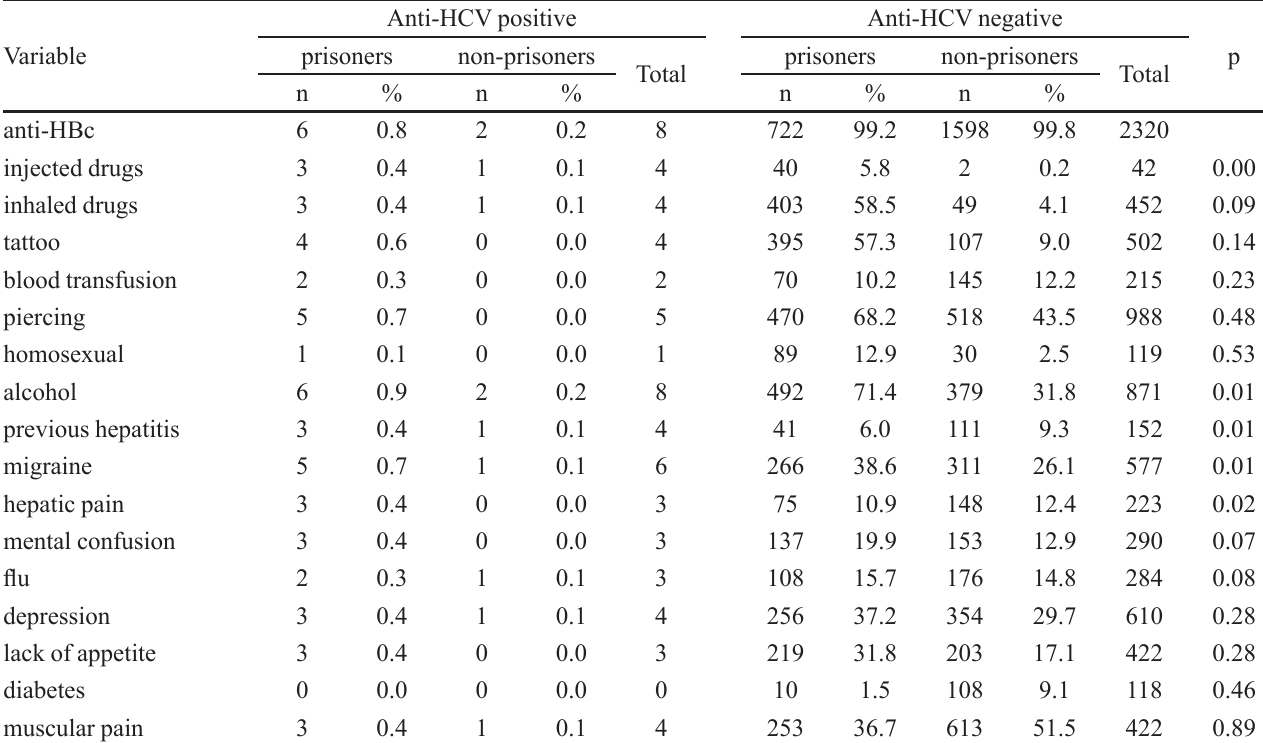
TABLE I - Correlation of risk factors and factors associated with hepatitis C